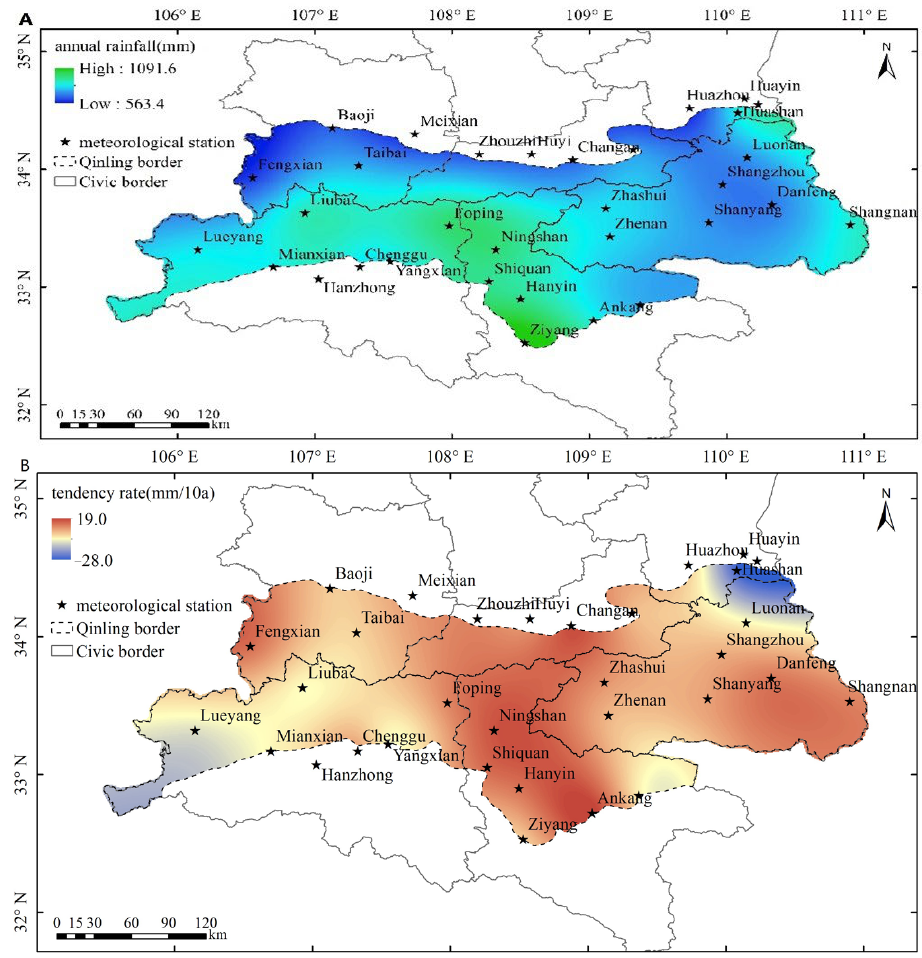
Figure 5. As in Figure 4, but for AMRA ( A ) (unit: mm) and AMRA trends ( B ) (unit: mm/10a).